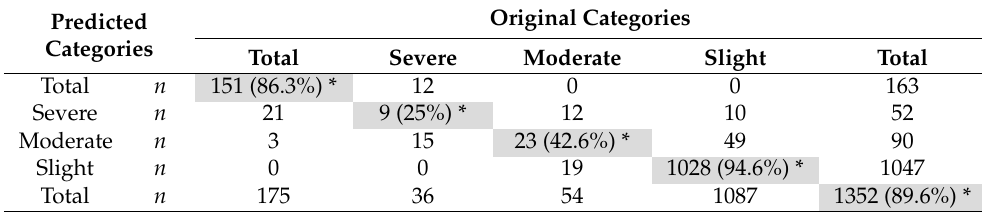
Table 4. Concordance Index between original and predicted Barthel index categories.